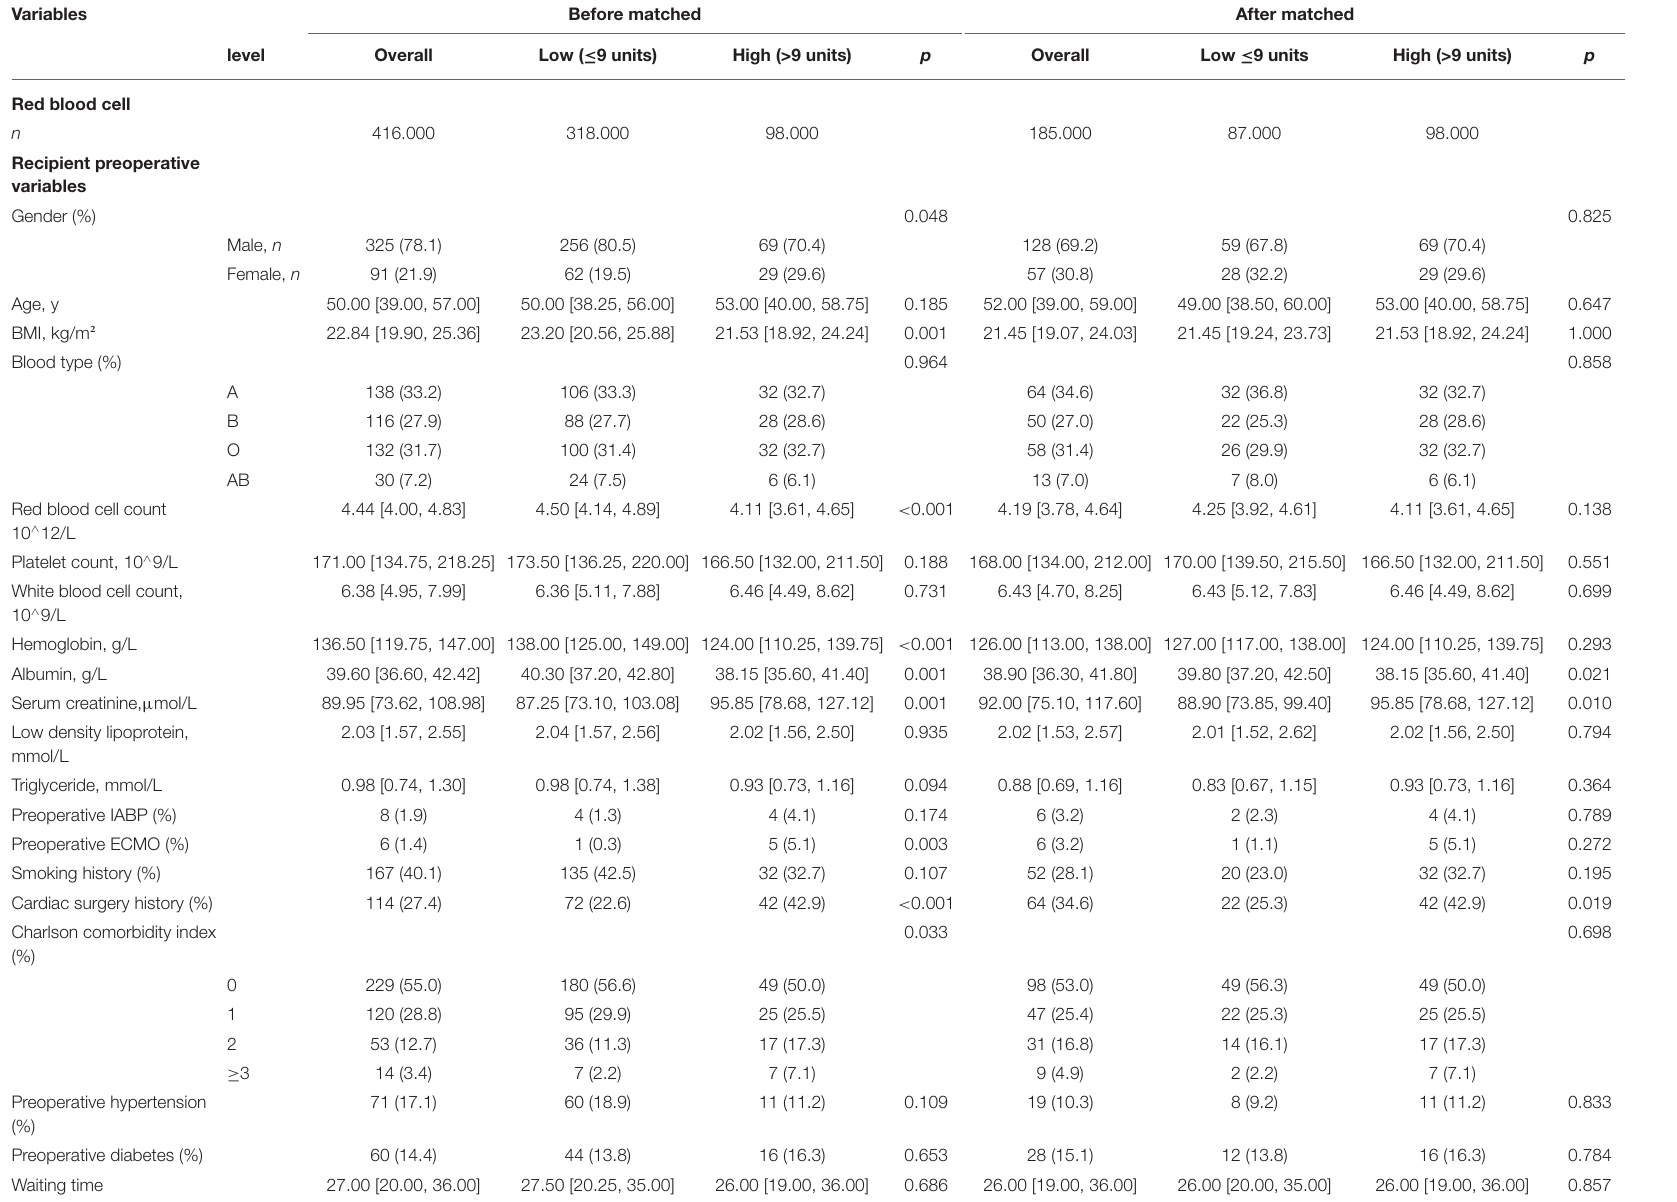
TABLE 1 | Baseline characteristics and operative data of the 416 patients in the study